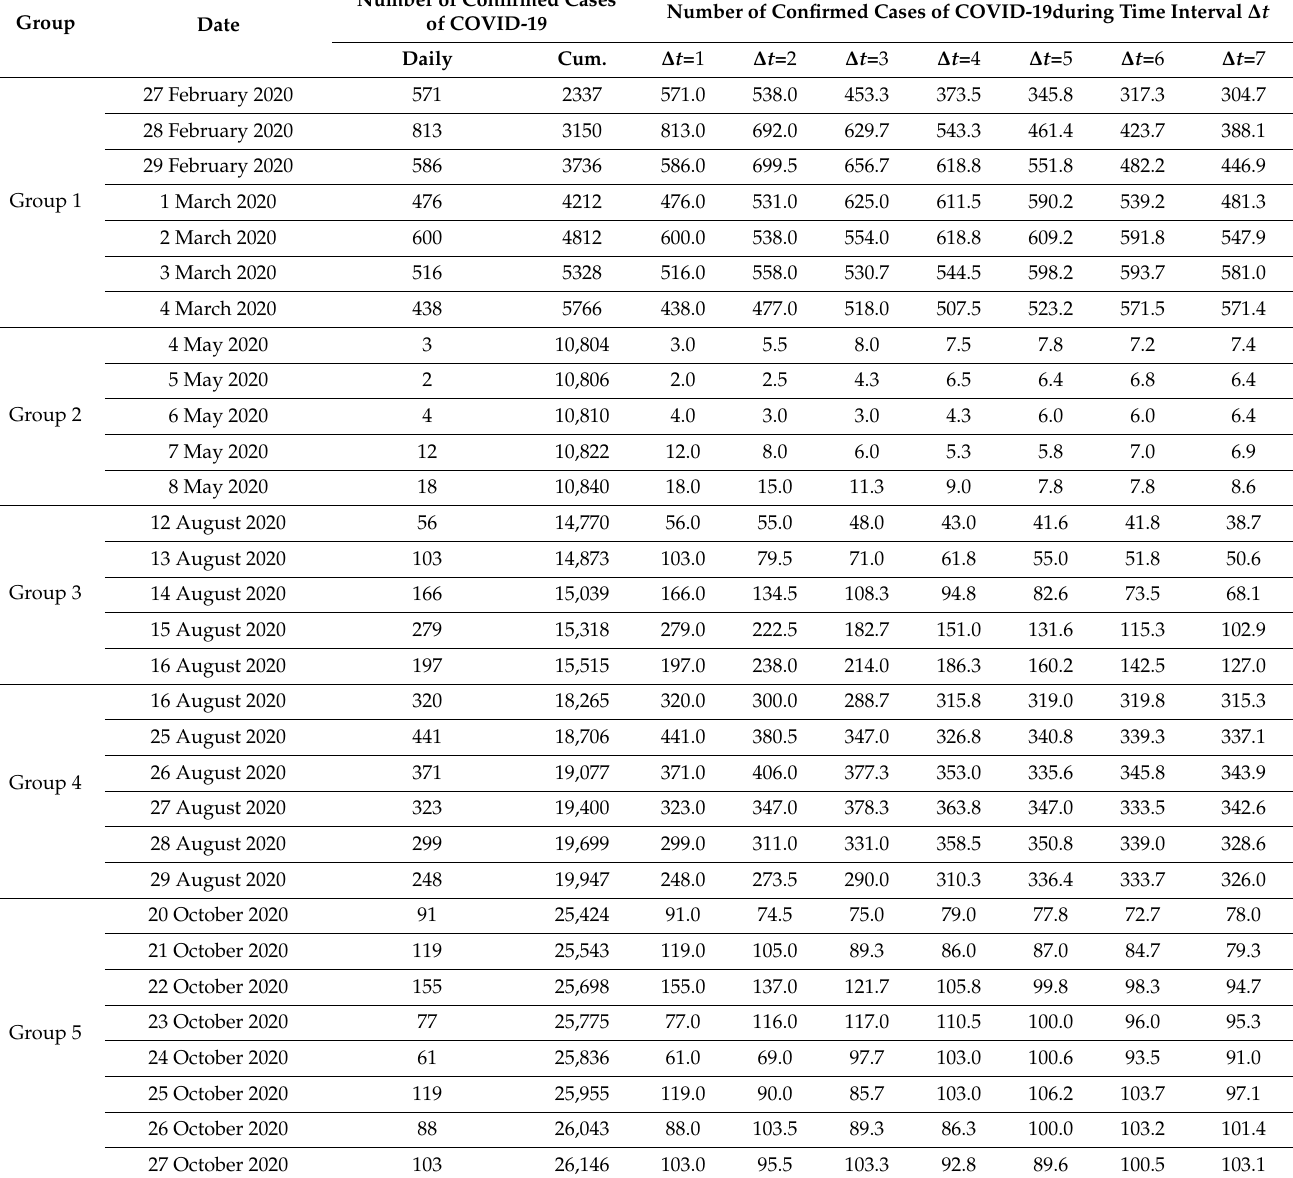
Table 1. The number of confirmed cases of COVID-19 during time interval ∆ t by Group.